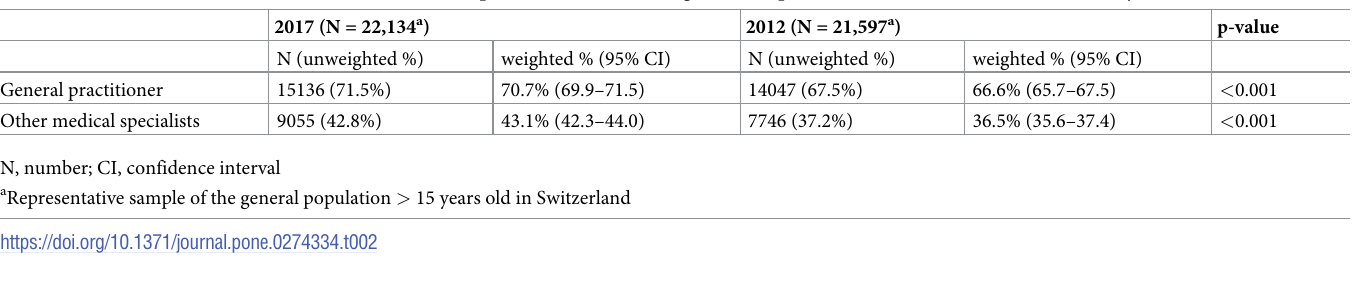
Table 2. Prevalence of conventional health care use in the past 12 months according to the telephone interviews from Swiss Health Survey 2012 and